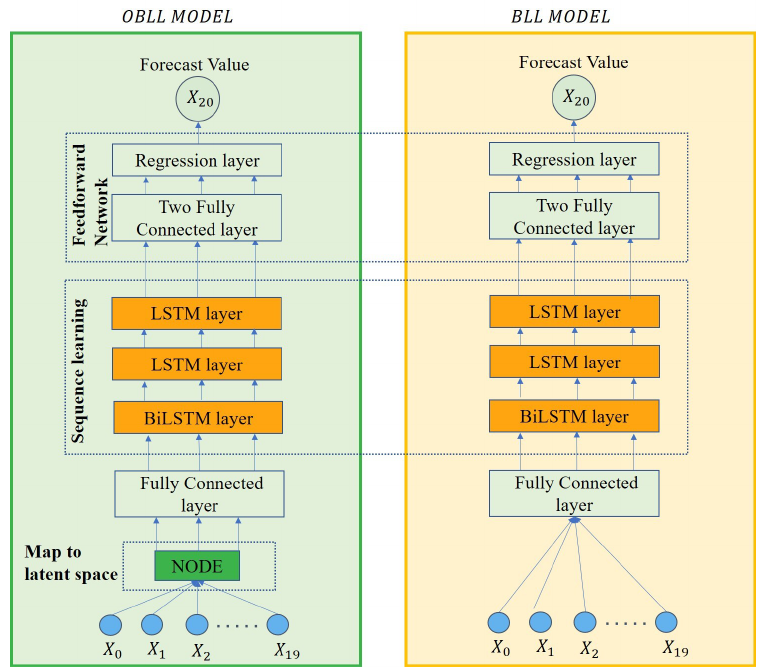
Figure 7. The model structures of OBLL and